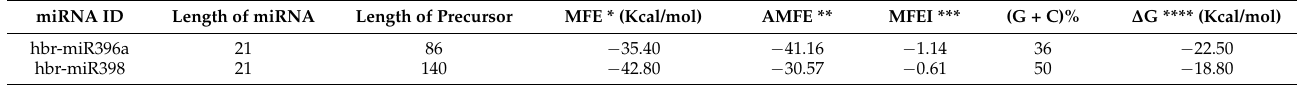
Table 2. The parameters of consensus secondary structures of precursor miRNAs.